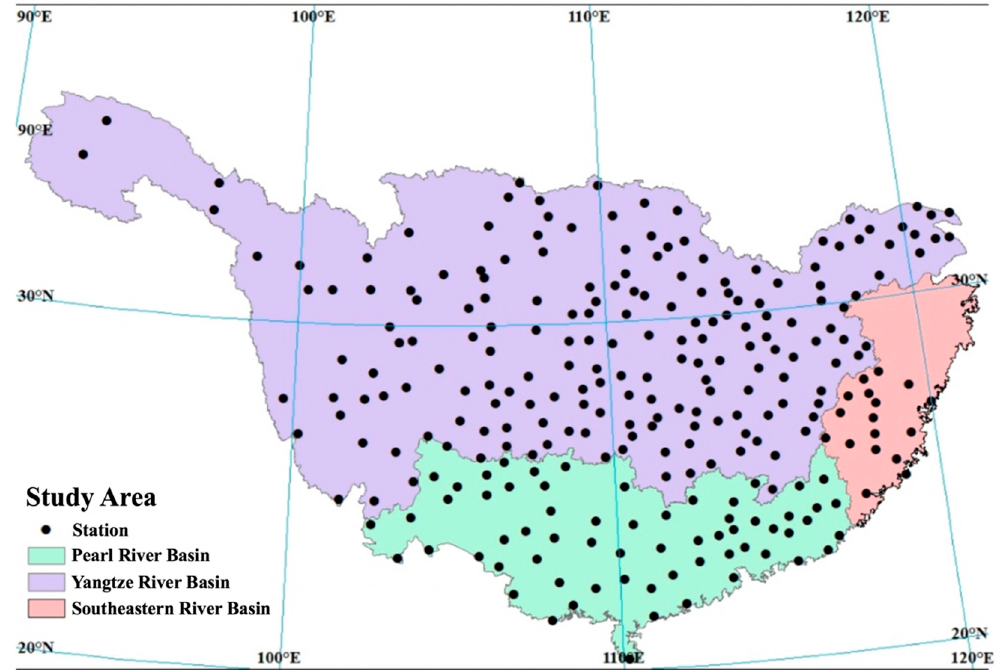
Figure 1. Map of southern China and location of meteorological stations used in this study.